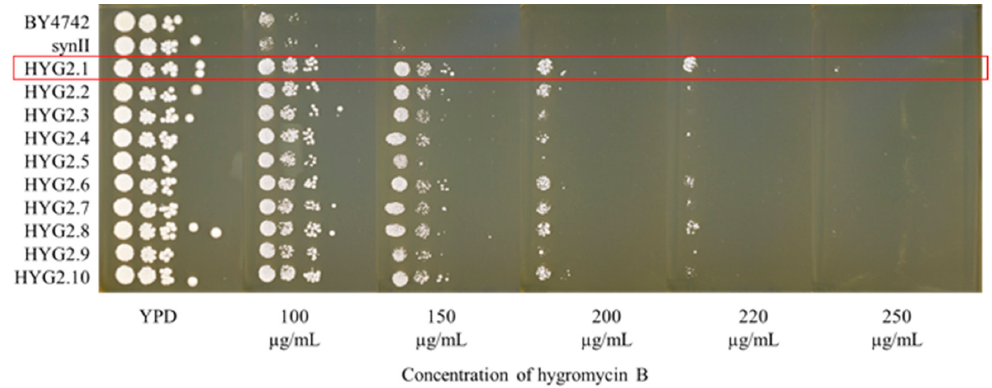
Figure 2. Spot test to assess hygromycin B resistance of the SCRaMbLEd strains HYG2.1-HYG2.10. SCRaMbLEd strains which grew at 200 μ g/mL hygromycin B concentration were isolated and spotted on YPD plates containing different concentrations of hygromycin B. The plates were incubated at 30 °C and the photos were taken on day 5. SCRaMbLEd yeast strain HYG2.1 shows improved growth at higher hygromycin B concentrations compared to the wild type and the parental synII